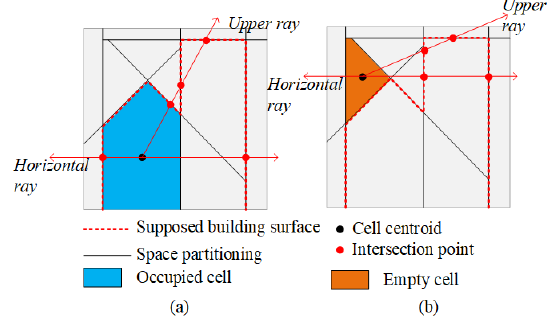
Figure 5. Occupied and empty cells illustrated in 2D.